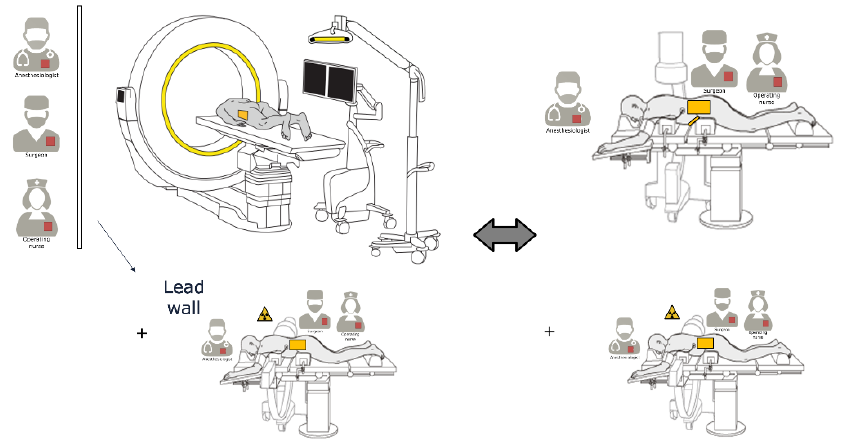
Figure 1. Schematic representations of iCT procedures ( left ) with the usage of iCT and lateral C-arm fluoroscopy and C-arm fluoroscopy procedures ( right ) with biplanar C-arm fluoroscopy. To evaluate the time efficiency of the surgeries, the duration of pedicle screw placement and the total operation time was measured. The total operation time length includes the time between the first incision and the last suture. The duration of pedicle screw placement was measured from narcosis to